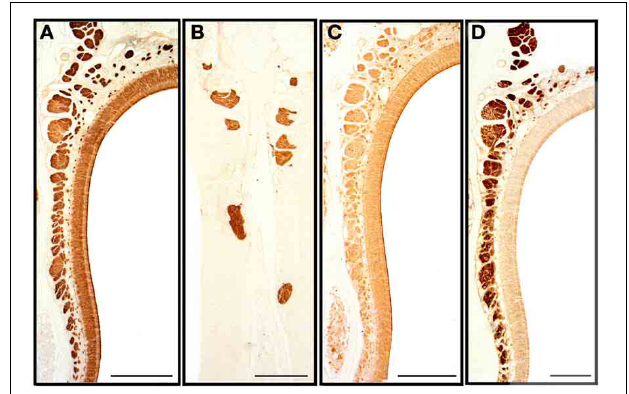
FIGURE 7 | Transverse sections of the nasal septum stained with anti-OMP (A), UEA-I (B), LEA (C) and anti-G α 0 (D), showing the olfactory sensory epithelium and the olfactory and vomeronasal nerve bundles. Scale bars: (A,C) 150 μ m; (B,D) 100 μ